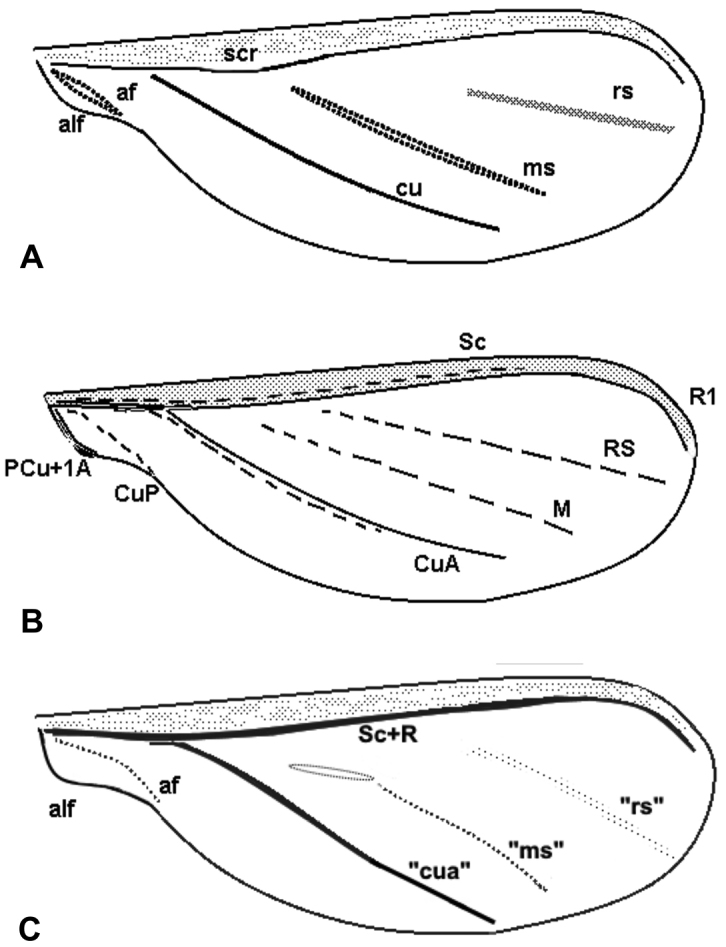
Schematic drawings of forewing of Orthezia
urticae (Linnaeus, 1758) after A
Koteja (1986)
B
Shcherbakov (2007)
C present interpretation.